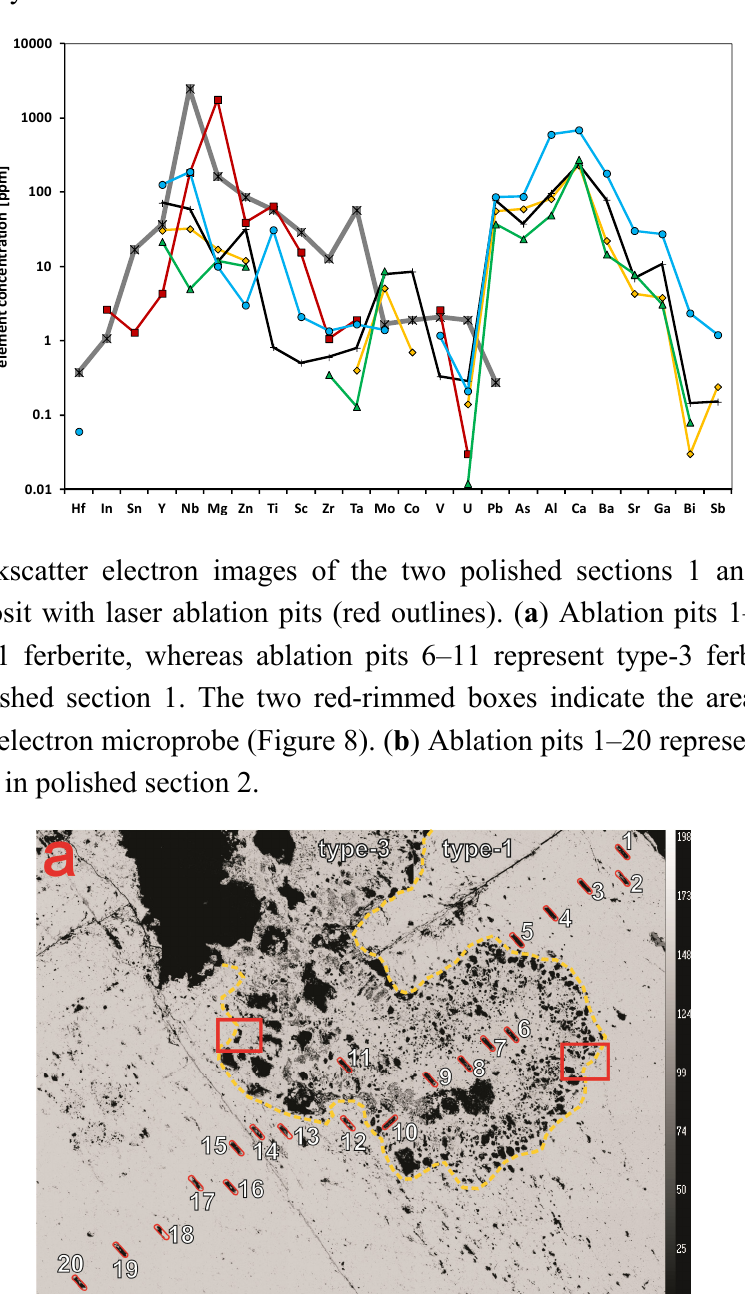
Figure 4. Spider diagram showing trace element composition of primary wolframite (worldwide occurrences) and ferberite from the Rwandan reinite deposits (Gifurwe, Nyakabingo, Bugarama). The data of ferberite from the Rwandan reinite deposits are given as median values of single analyses for each sample locality (Gifurwe, Nyakabingo, Bugarama: type-1, type-2, type-3). The data for primary wolframite are given as the median value of single analyses ( n = 1094) for 23 sample localities worldwide. Data points below the detection limit are omitted. Please note that the trace element concentrations are displayed on the logarithmic scale. Gifurwe = yellow line and diamonds, Nyakabingo = black line and crosses, Bugarama: type-1 = red line and squares, type-2 = green line and triangles, type-3 = blue line and circles and primary wolframite from different deposits worldwide = gray line and asterisks.